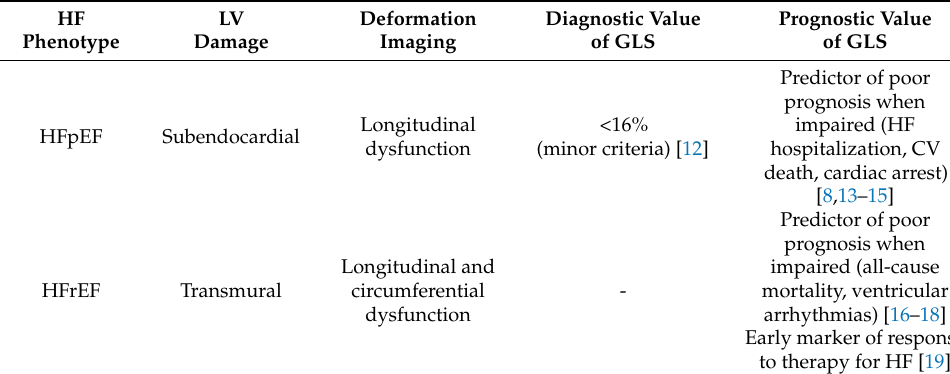
Table 1. Diagnostic and prognostic role of strain pattern according to HF